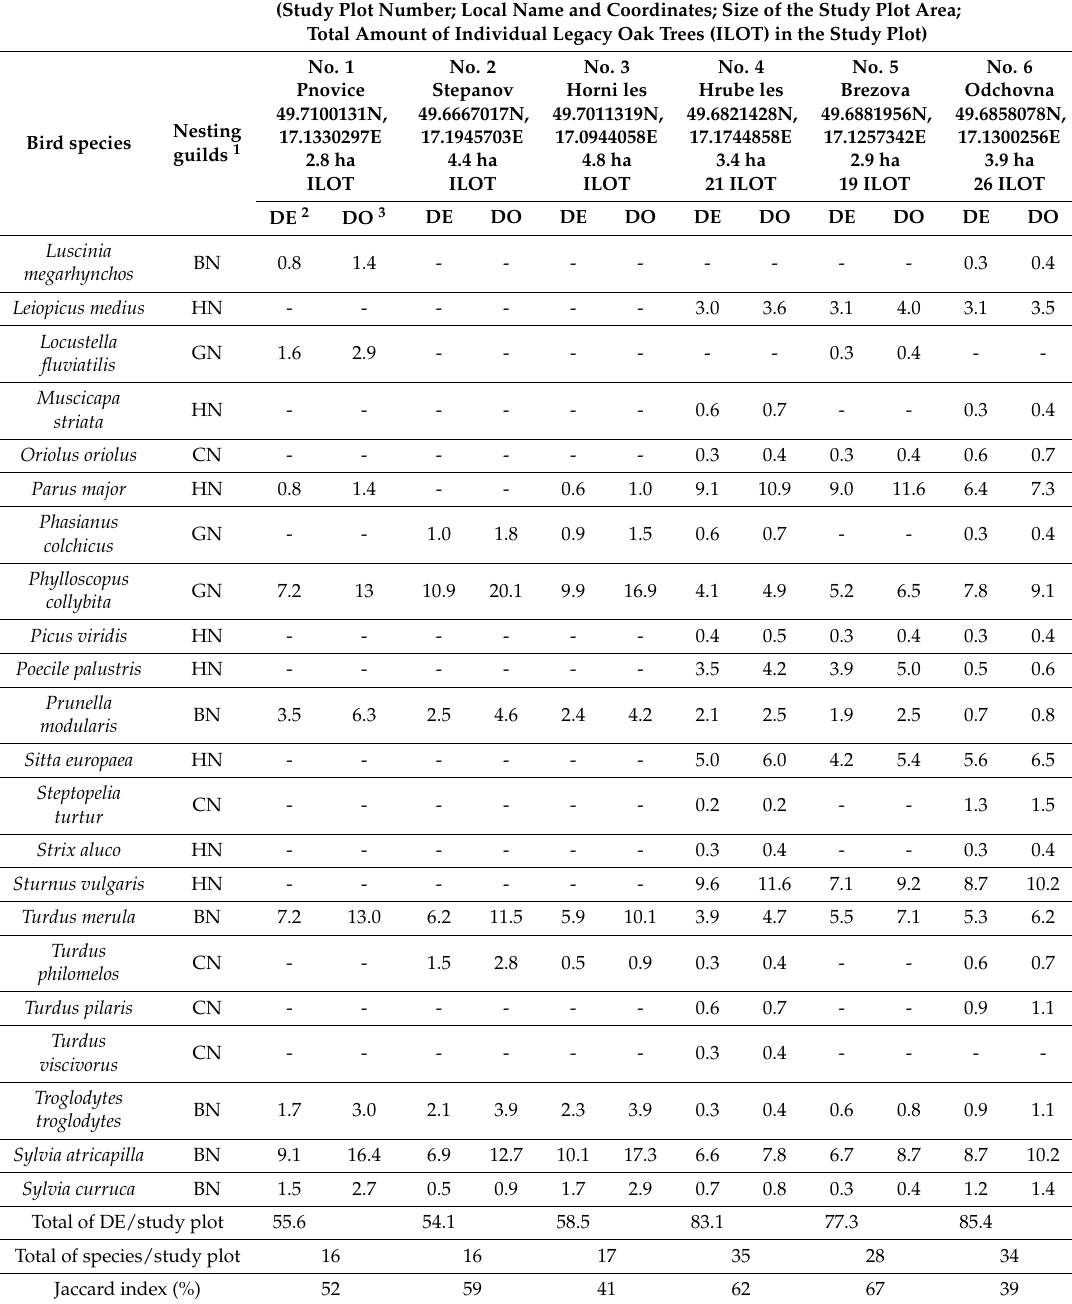
Table 1. Cont. Study Plots (Study Plot Number; Local Name and Coordinates; Size of the Study Plot Area; Total Amount of Individual Legacy Oak Trees (ILOT) in the Study